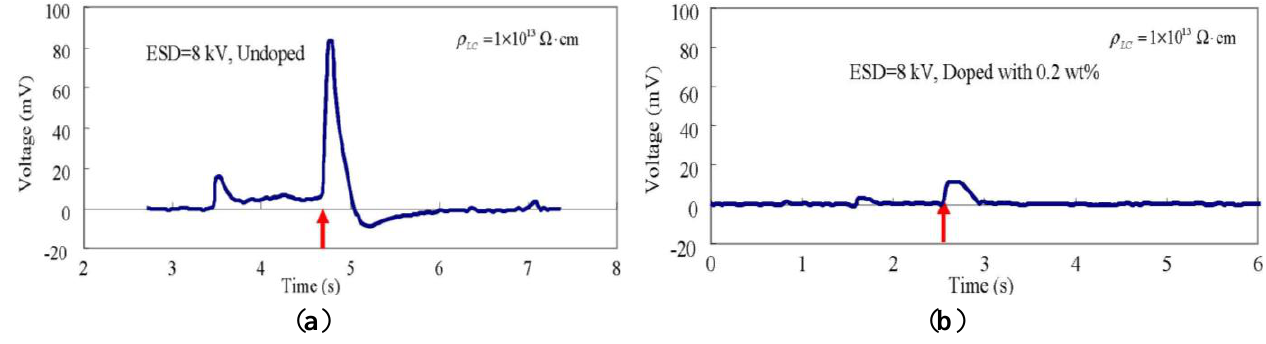
Figure 14. Effect of the ITO concentration on the accumulated charges induced by ESD. The x -axis indicates the concentration of the ITO doped in the LC. The data for the undoped sample is shown at the point for 0.00 wt